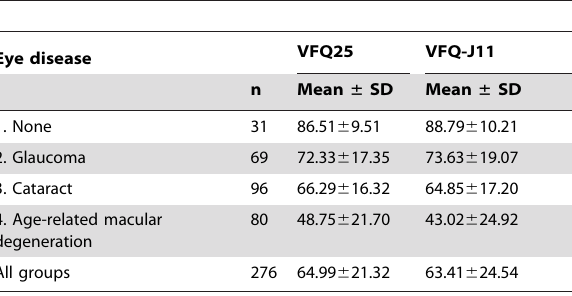
Table 3. Scores on the VFQ25 and VFQ-J11 in patients with different eye diseases.